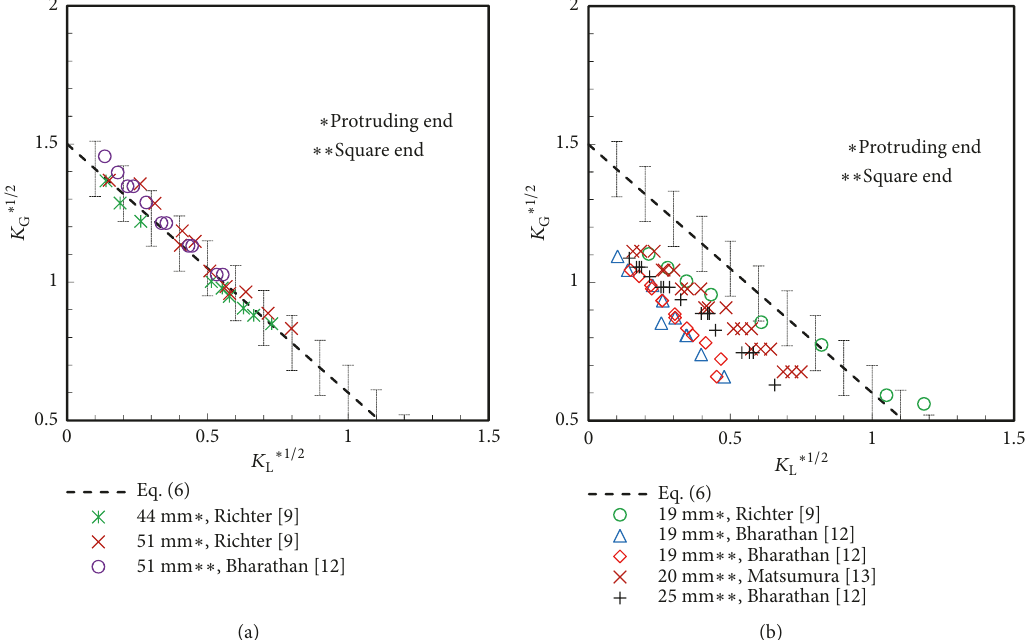
Figure 5: CCFL characteristics in (a) medium diameters and (b) small diameters with water levels at midlevel (except D = 19 mm by Richter